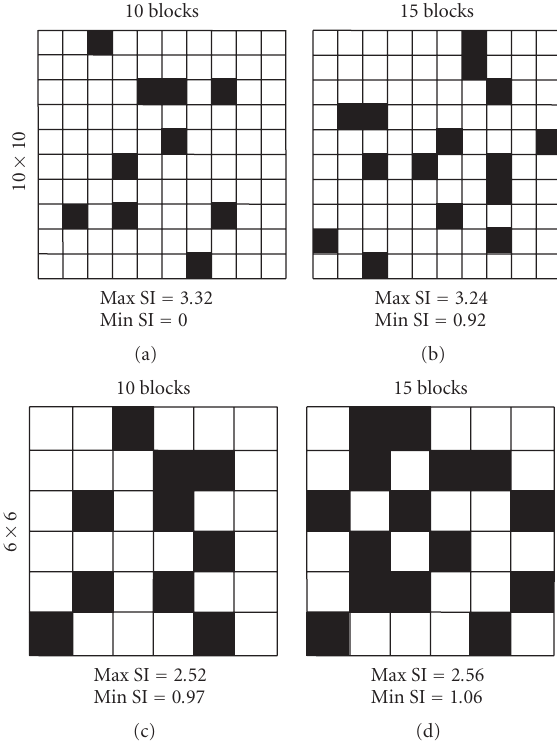
Figure 4: The range of Shannon Index (SI) changes depending on the number of data points and the bin size . As examples, when 10 (left) and 15 (right) blocks are distributed in the 10 × 10 (top) and 6 × 6 (bottom) squared spaces, the maximal and minimal SI values are shown in each